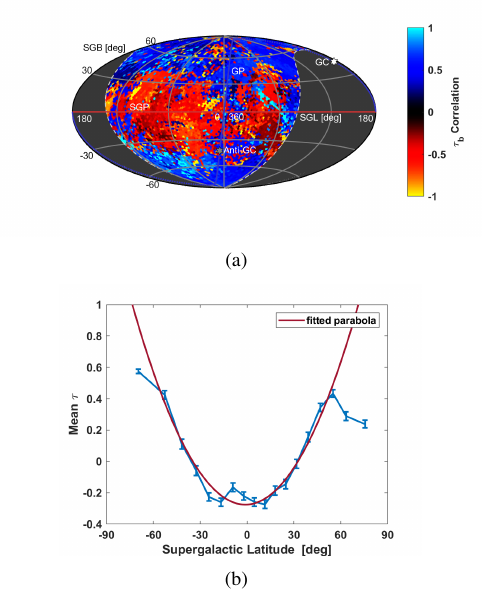
Figure 6. Data result. (a) Projection of the correlation strength τ b for all grid points. Negative correlations expected for magnetic deflections are apparent around the supergalactic plane. Solid curves indicate the galactic plane (GP) in blue and supergalac- tic plane (SGP) in red. White and grey hexagrams indicate the Galactic center (GC) and anti-galactic center (Anti-GC) respec- tively. (b) Mean τ b inside equal solid angle bins. The correlation curvature for the data is a = 2 . 4 × 10 − 4 .